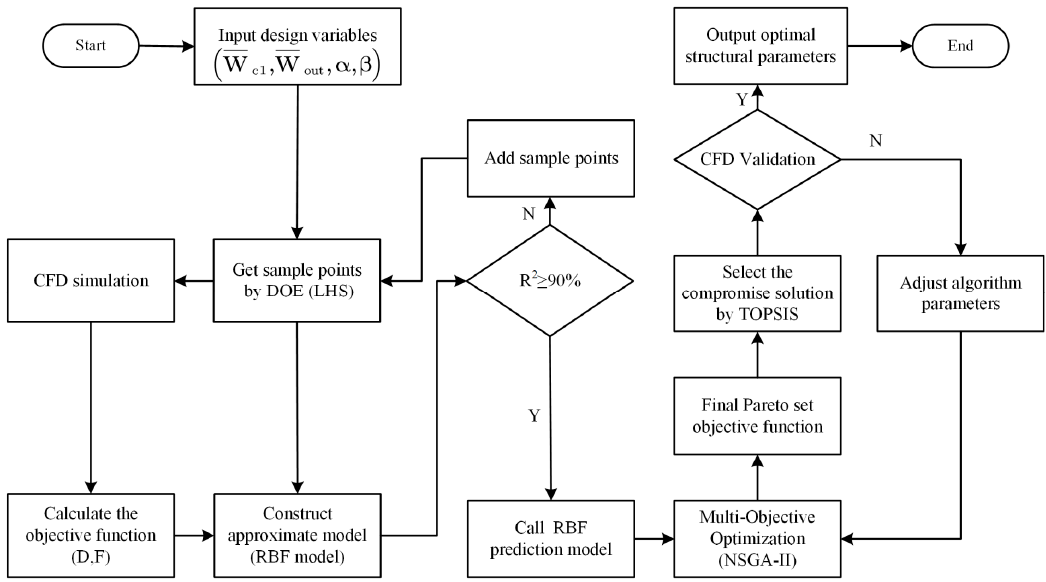
Figure 5. Multi-objective optimization flow chart.